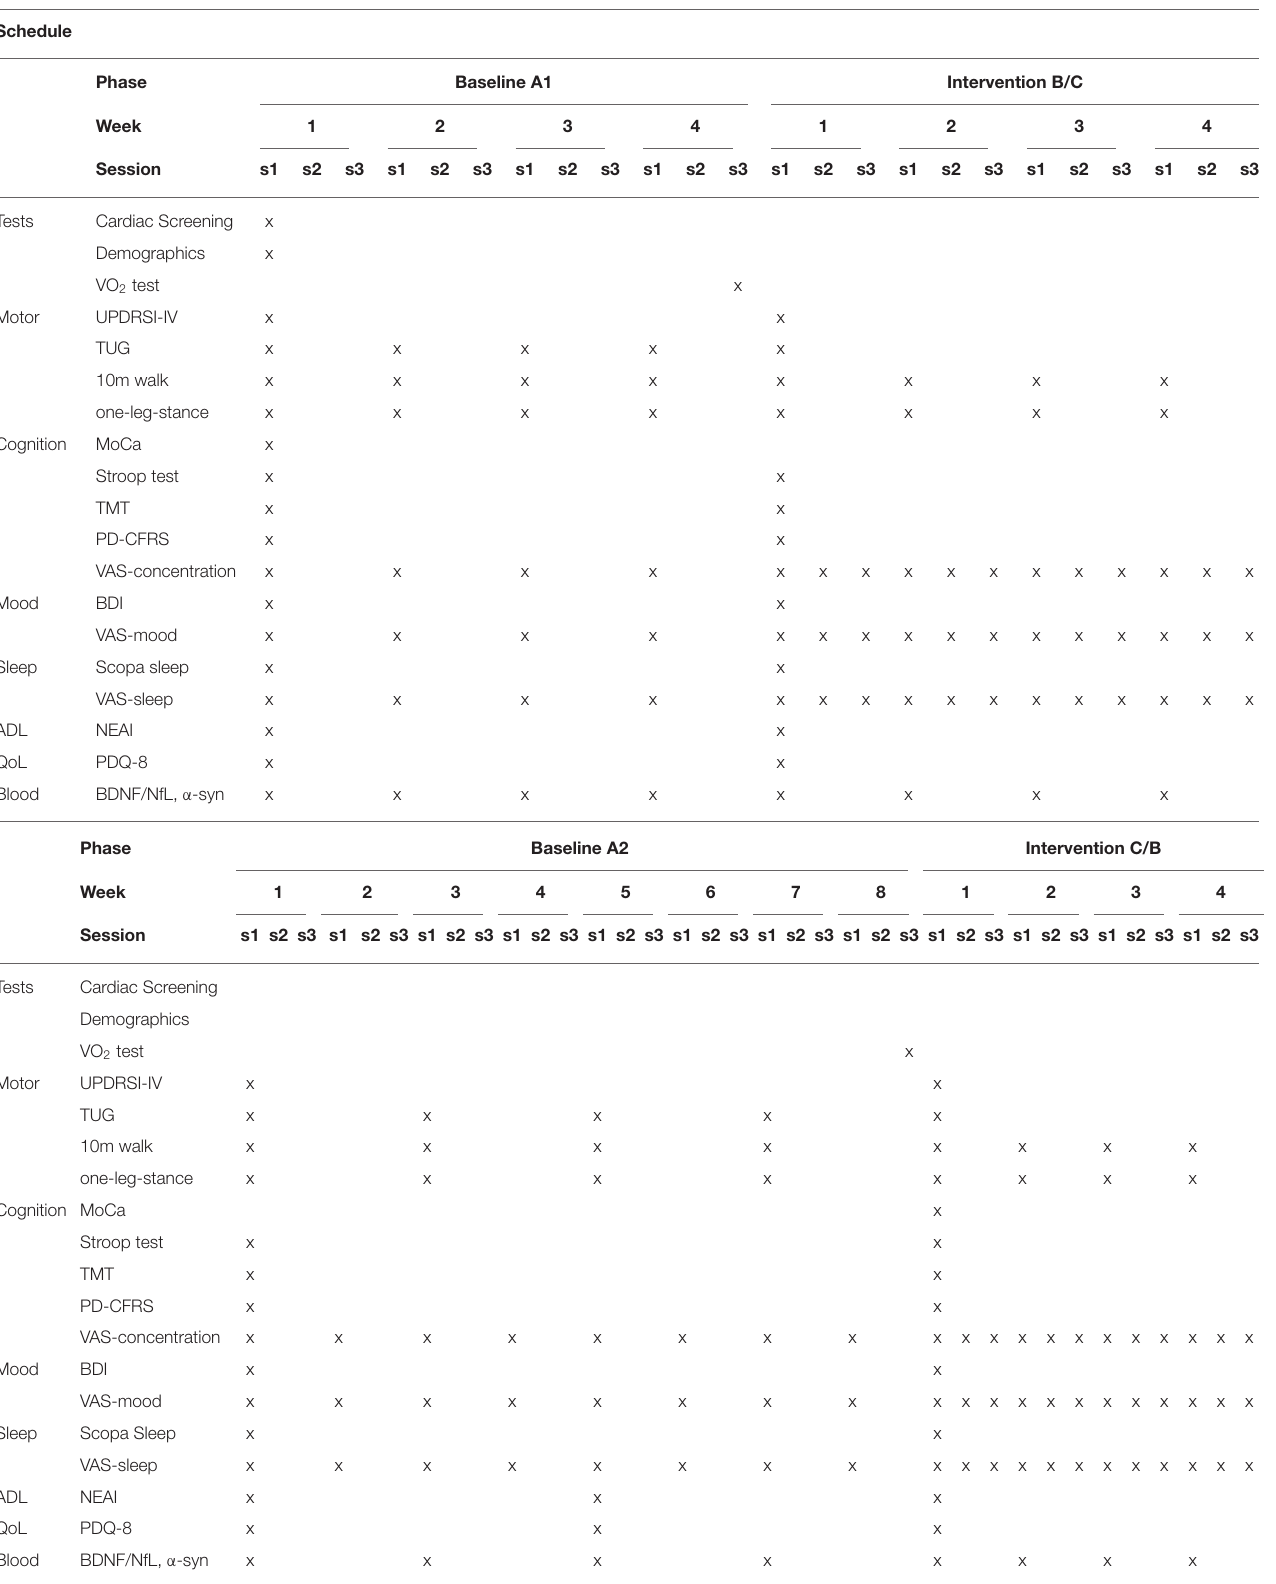
TABLE 1 | Assessment schedule for outcomes across the 28-week study